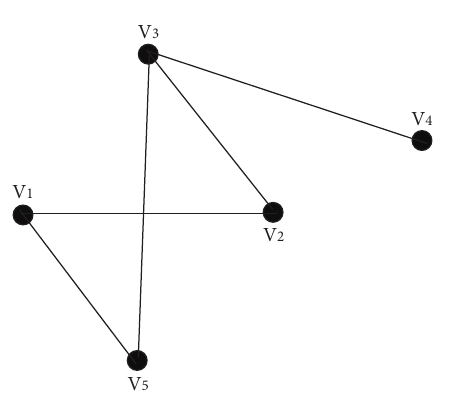
Figure 3: Te geometric realization of G